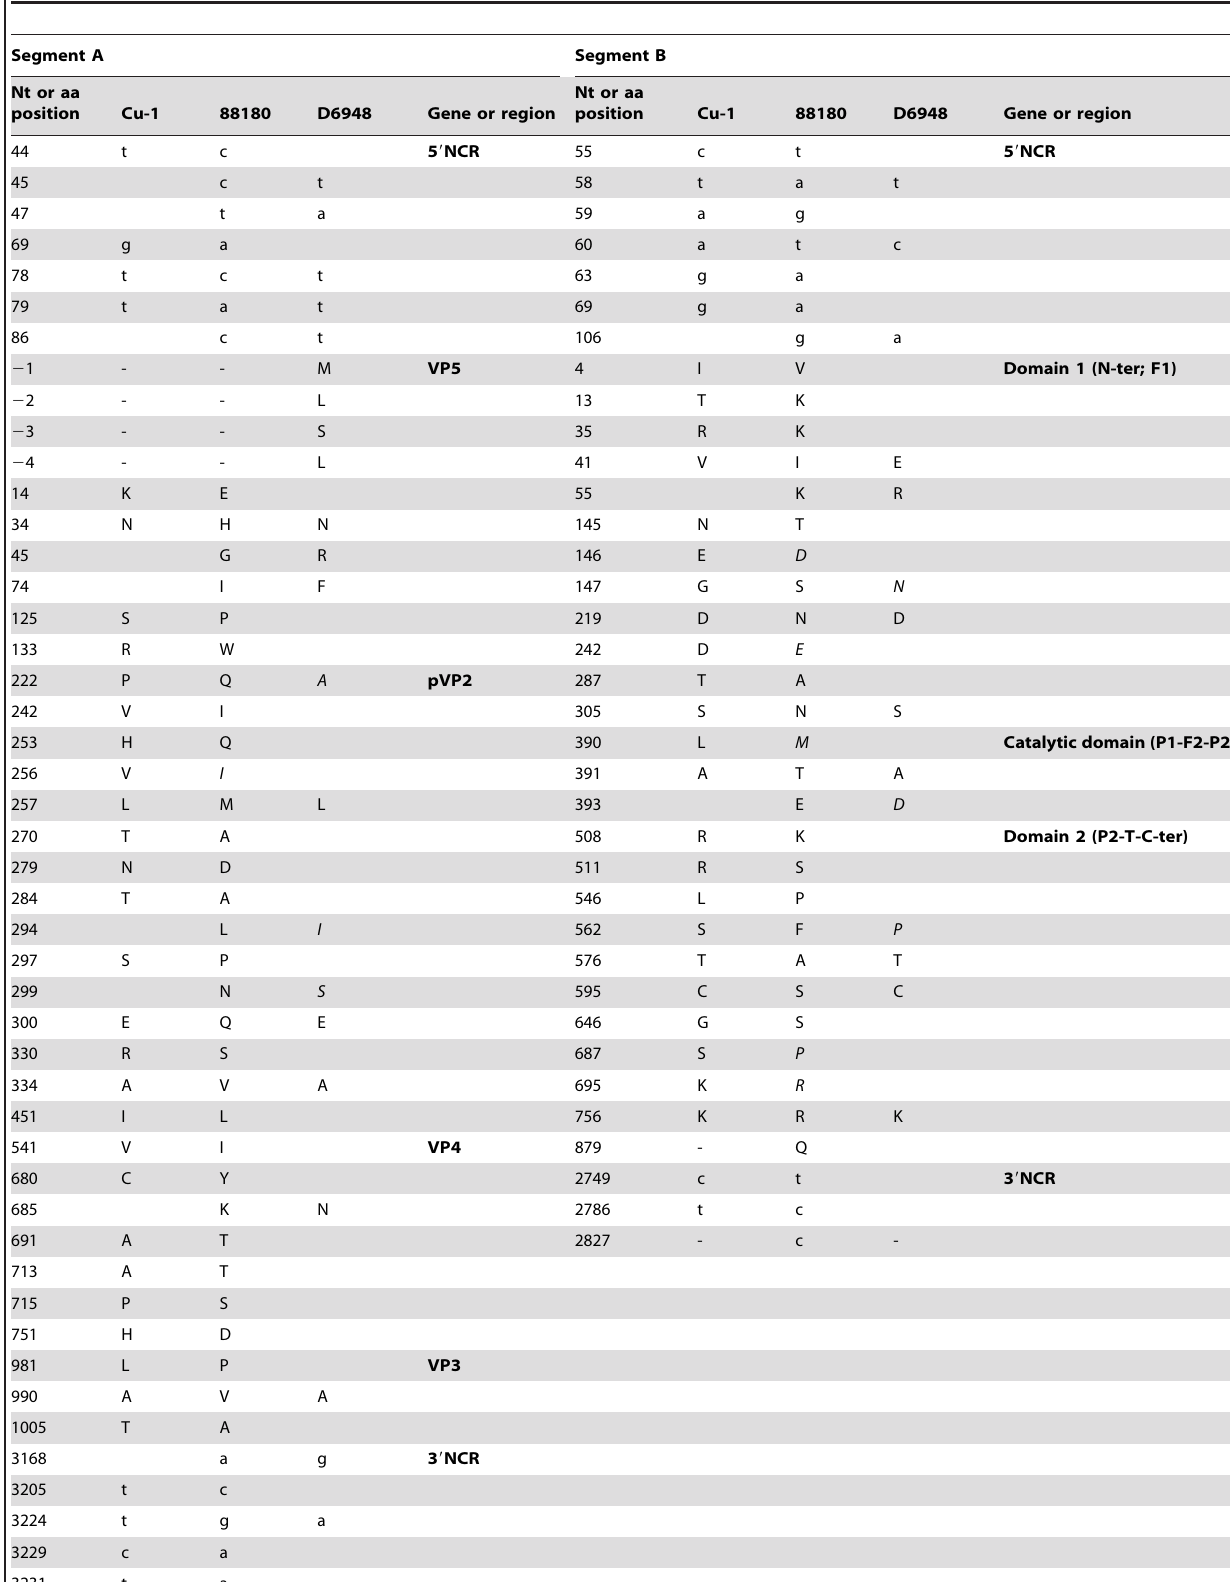
Table 1. Location of the nucleotide (non coding regions) or amino acid (coding regions) differences in both genome segments between 88180, Cu-1 and typical vvIBDV strain D6948 (Acc No AF240686 and AF240687 for segments A and B,